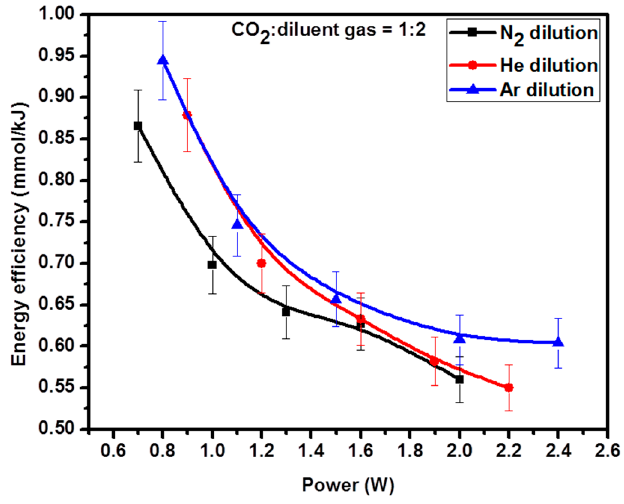
Figure 8. Energy efficiency with the variation of power at different diluent gases. (Flow rate 30 mL/min, CO 2 :diluent gas = 1:2, Glass beads packed DBD, Plasma frequency 50 Hz).